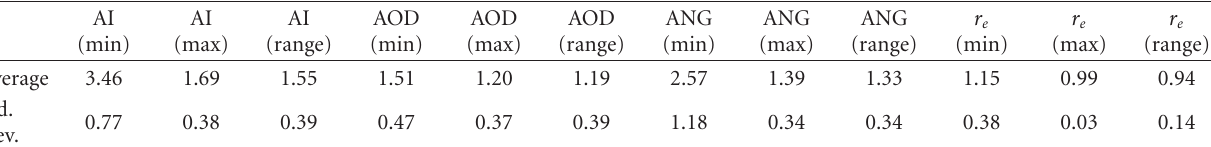
Table 2: Statistical summary of the ACI r analysis shown in Figure 3. The numbers reported below represent ratios of a particular parameter between periods of relatively high chlorophyll A ( > 0.3mgm − 3 ; October–February) versus low chlorophyll A ( < 0.3mgm − 3 ; April–August). The average and standard deviation calculations are based on 11 values representing individual LWP bins between 50 and 350 g m − 2 . These results represent 27 months of data starting in June 2006 for the Southern Ocean region (42 ◦ S–60 ◦ S, 180 ◦ W–180 ◦ E). (AI = aerosol index;